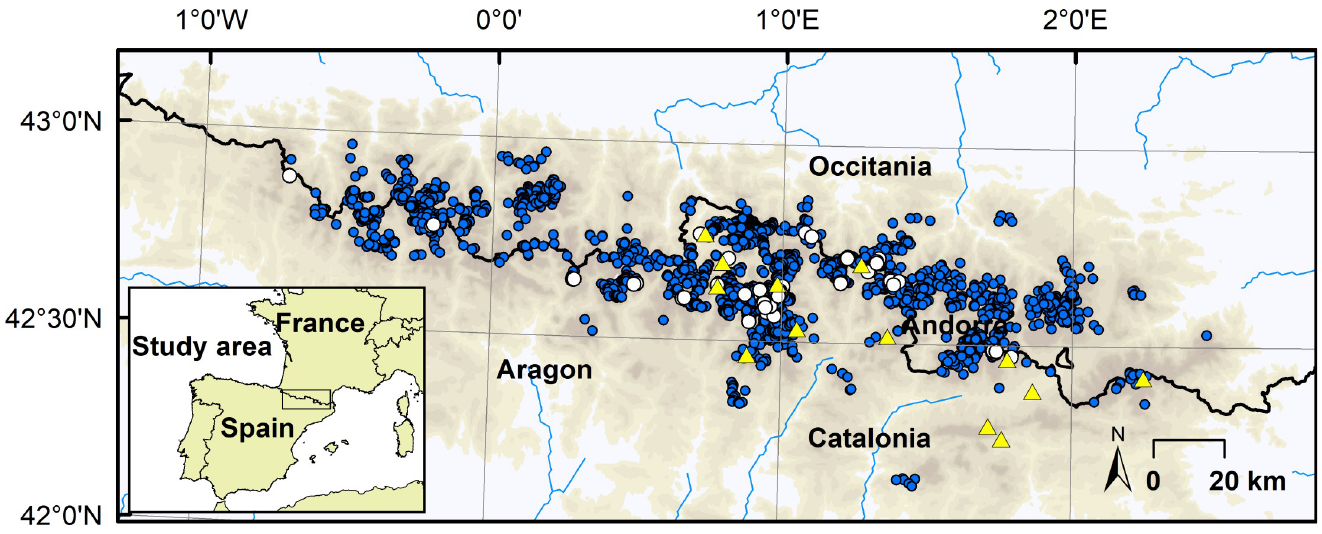
Fig 1. Map of the studied Pyrenean